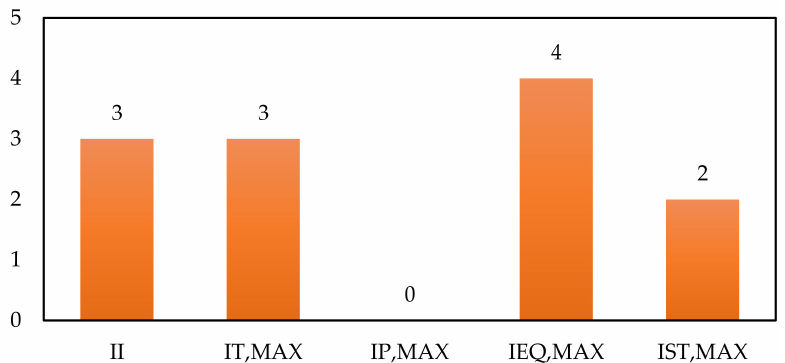
Figure 3. Contribution of PSI